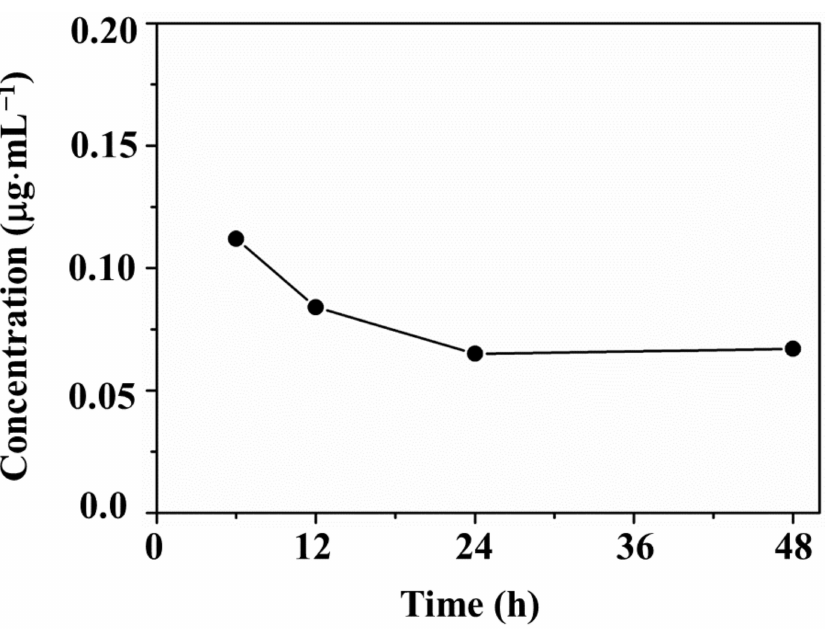
Figure 6. Concentration of Cu(II) ions released from PS@Cu-MOF (1 mg) in 0.9% PBS (1